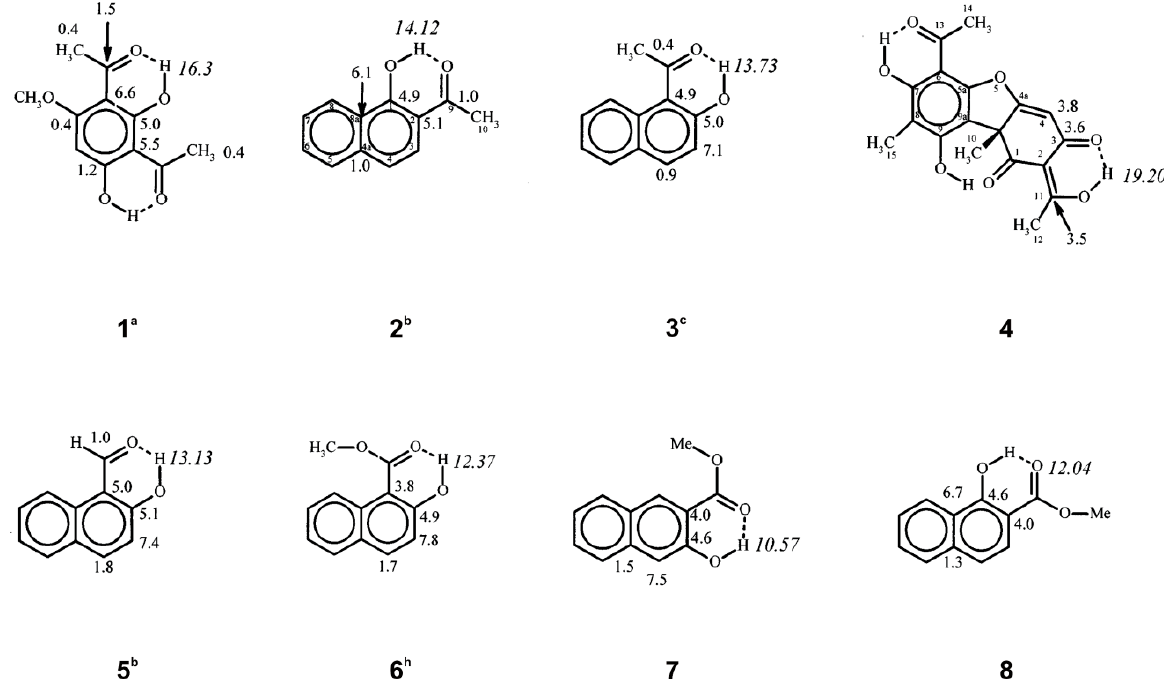
Figure 19. Observed OH chemical shifts (ppm) and n J ( 13 C, O 1 H) coupling constants